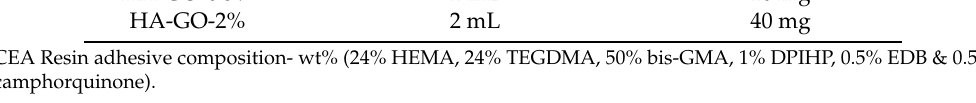
Table 1. Components of the two new adhesives with GO nanoparticles produced for this study Categories CEA Resin Adhesive (5% HA) Nanoparticles (mg)